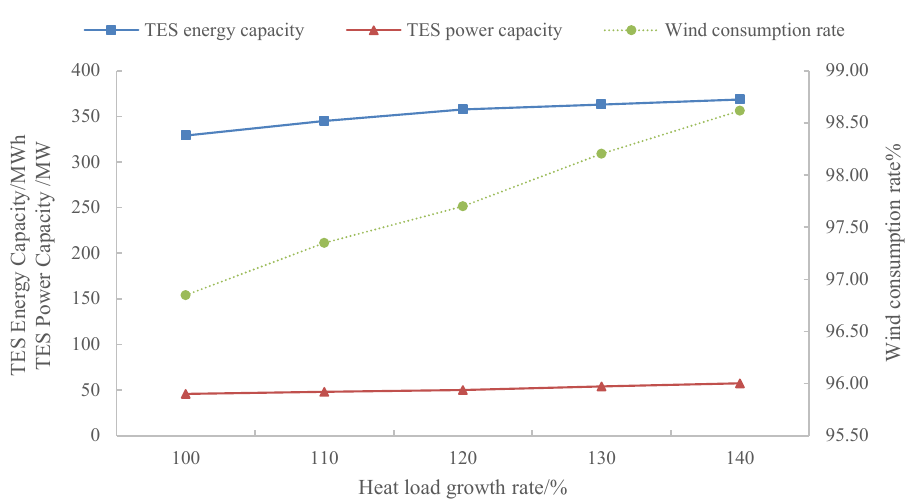
Figure 13. The impact of increased heat load on TES configuration and wind power